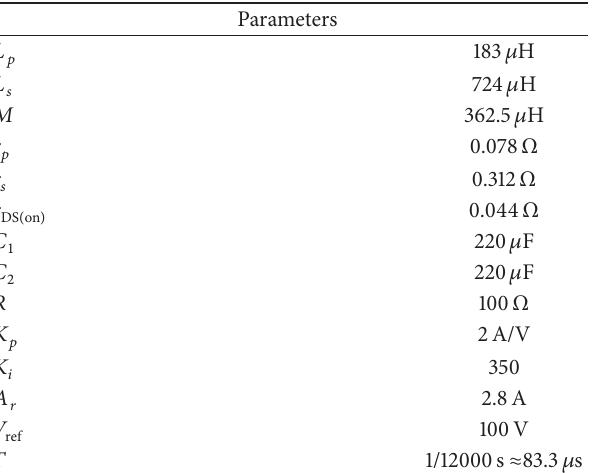
Table 2: Parameter